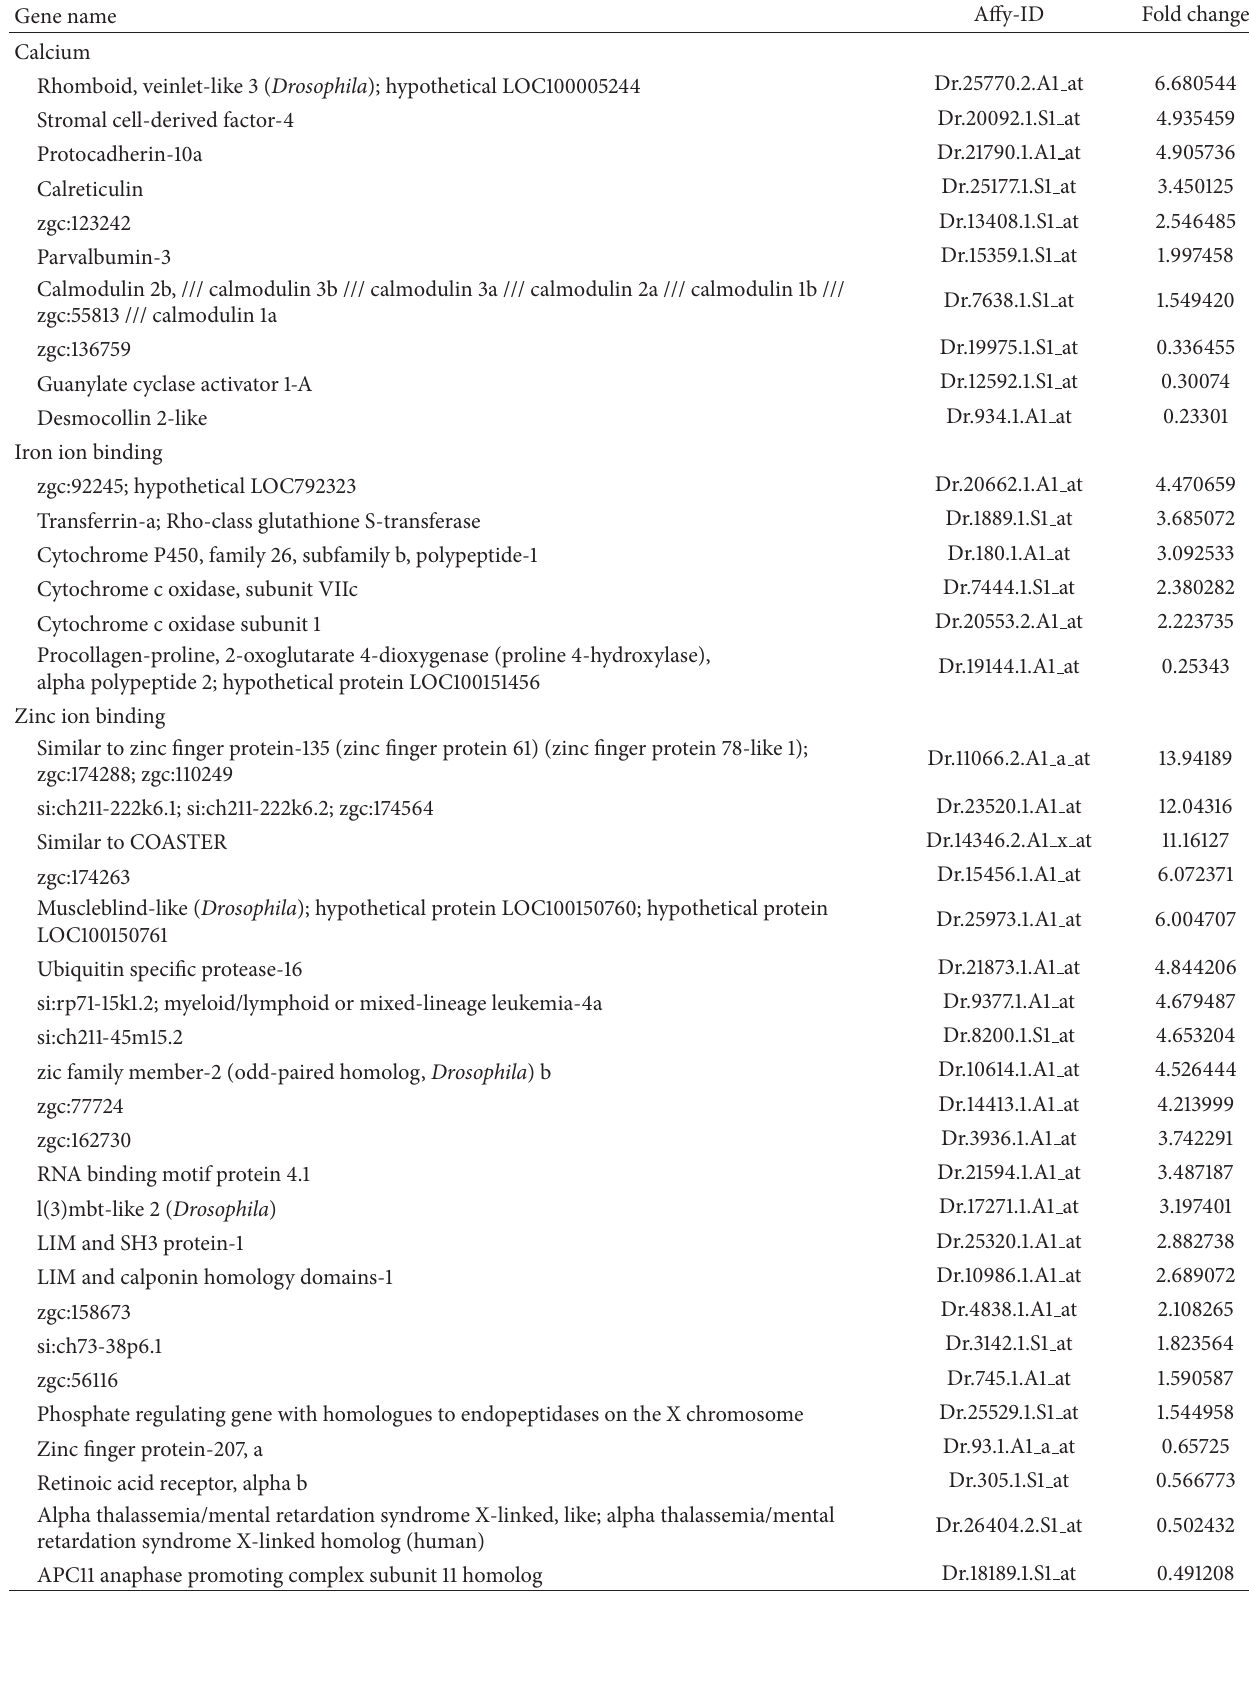
Table 5: Differentially expressed genes involved in metal ions and vitamin metabolism in the muscle of crisp grass carp and grass